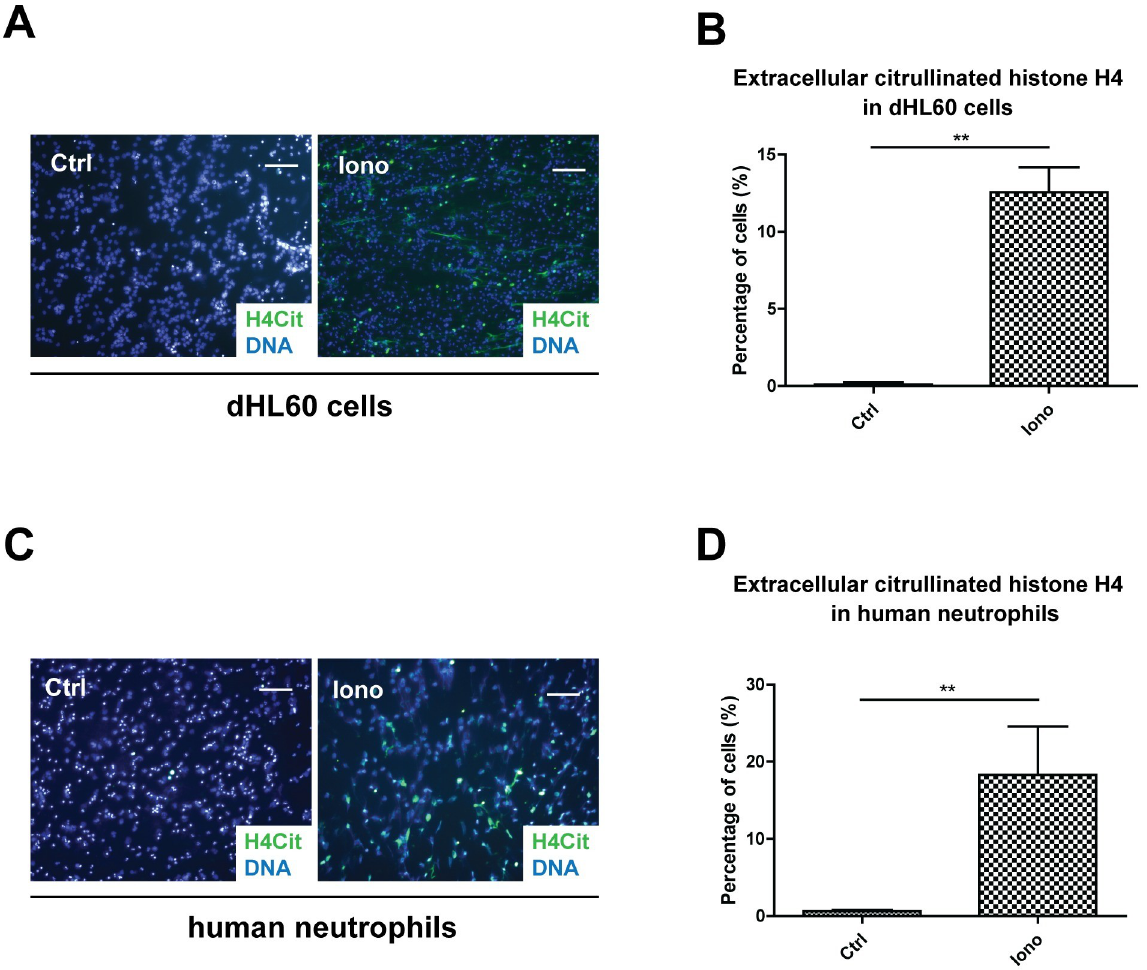
Fig 1. Citrullinated histone H4 is released into extracellular space in the process of NET formation. (A) Representative immunofluorescence images of dHL60 cells showing extracellular citrullinated histone H4 staining after 4 hours of ionomycin (iono) treatment with staining for H4Cit (green) and nuclei (blue). Scale bars, 100 μ m. (B) Quantification of extracellular histone H4 staining in dHL60 cells after ionomycin treatment. Mean ± SD is shown ( n = 3 independent experiments). (C) Representative immunofluorescence images of human neutrophils showing extracellular citrullinated histone H4 staining after 4 hours of ionomycin treatment with staining for H4Cit (green) and nuclei (blue). Scale bars, 100 μ m. (D) Quantification of extracellular histone H4 staining in human neutrophils after ionomycin treatment. Mean ± SD is shown ( n = 3 independent experiments). �� , P < 0.01. Ctrl, unstimulated